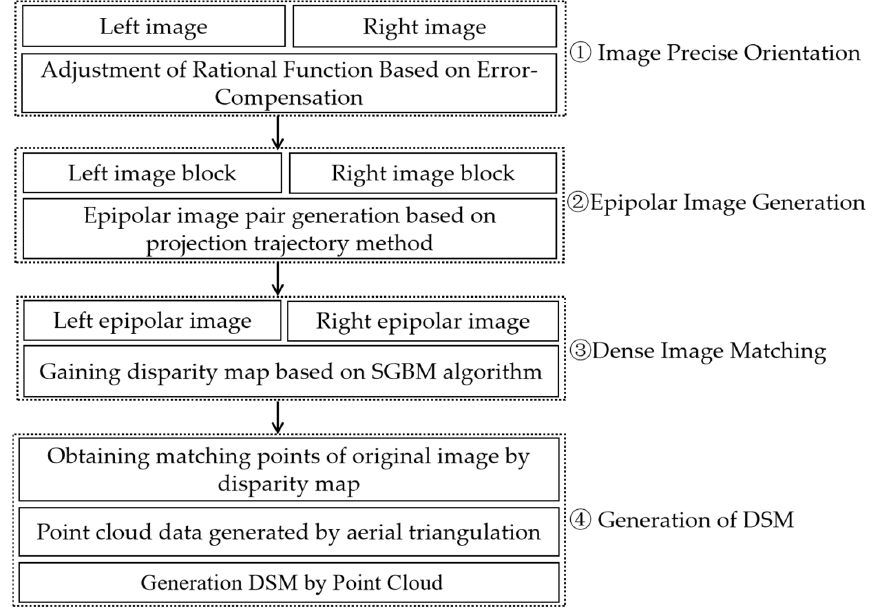
Figure 2. The flowchart of DSM extraction using GF-6 satellite images.